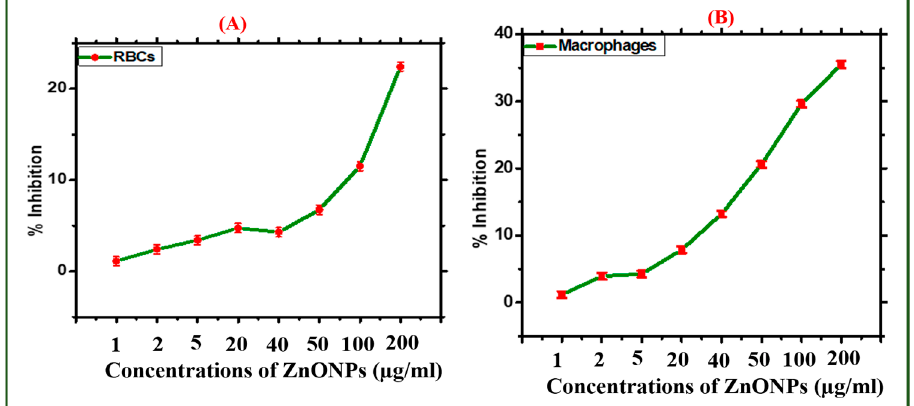
Figure 7. Biocompatibility potential assay of biosynthesized zinc oxide NPs. The data in all figures represent the mean (average) of three replicates. ( A ) Biocompatibility with human RBCs; ( B ) biocompatibility with human macrophages.